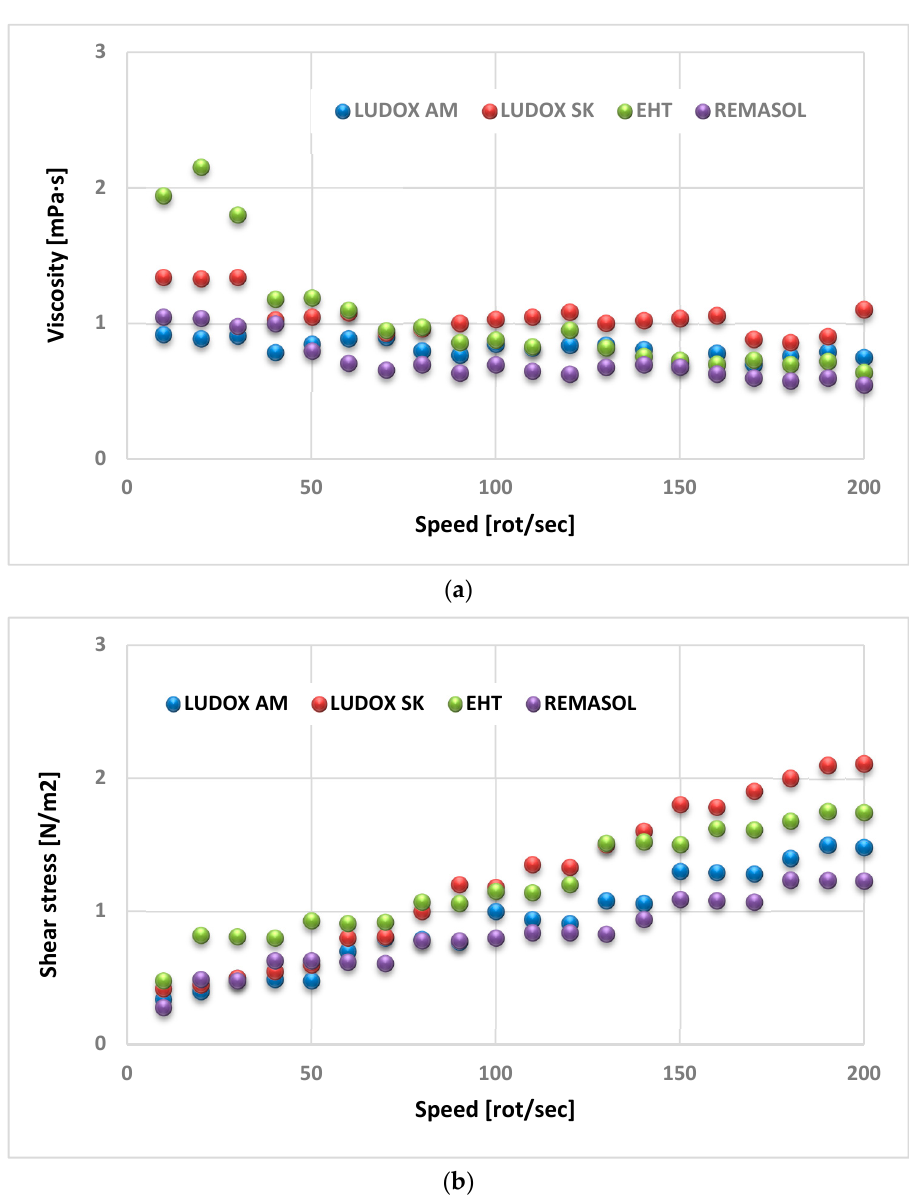
Figure 17. Dependence of ( a ) dynamic viscosity and ( b ) shear stress on shear rate for colloidal silica-based binders.